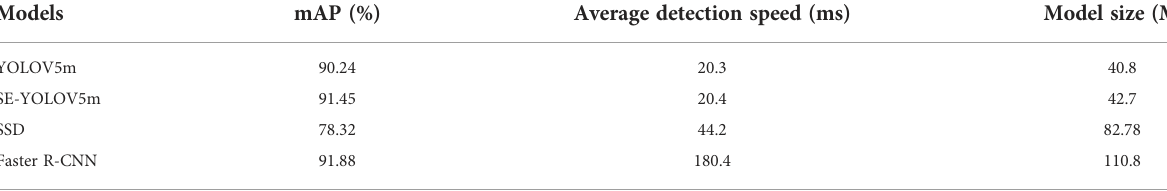
TABLE 2 Comparison of different detection models on the test set.